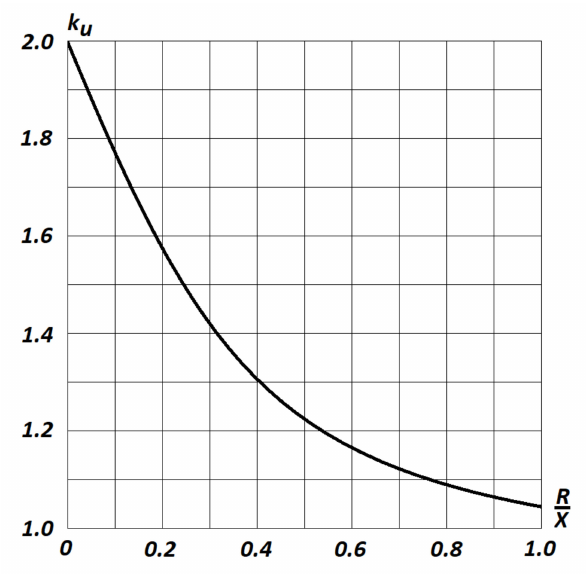
Figure 4. Surge factor